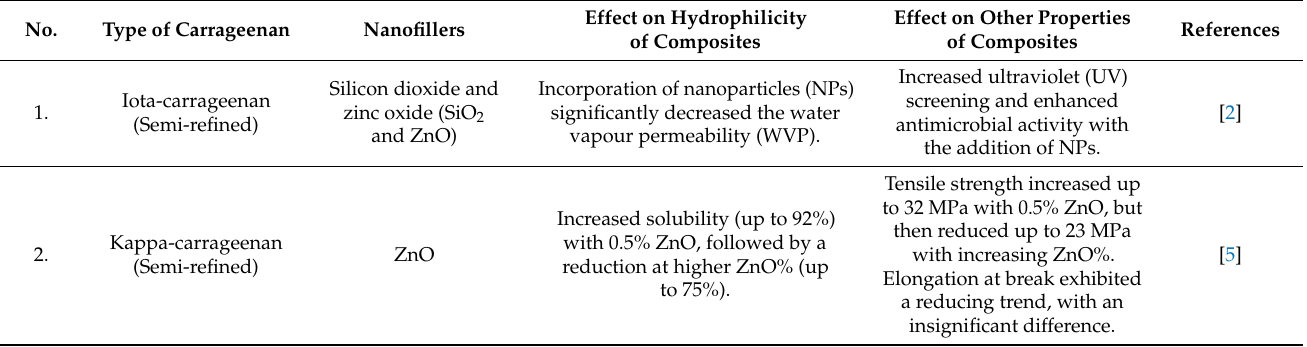
Table 2. Effect of carrageenan type (kappa vs. iota) on the hydrophilicity of the composites.